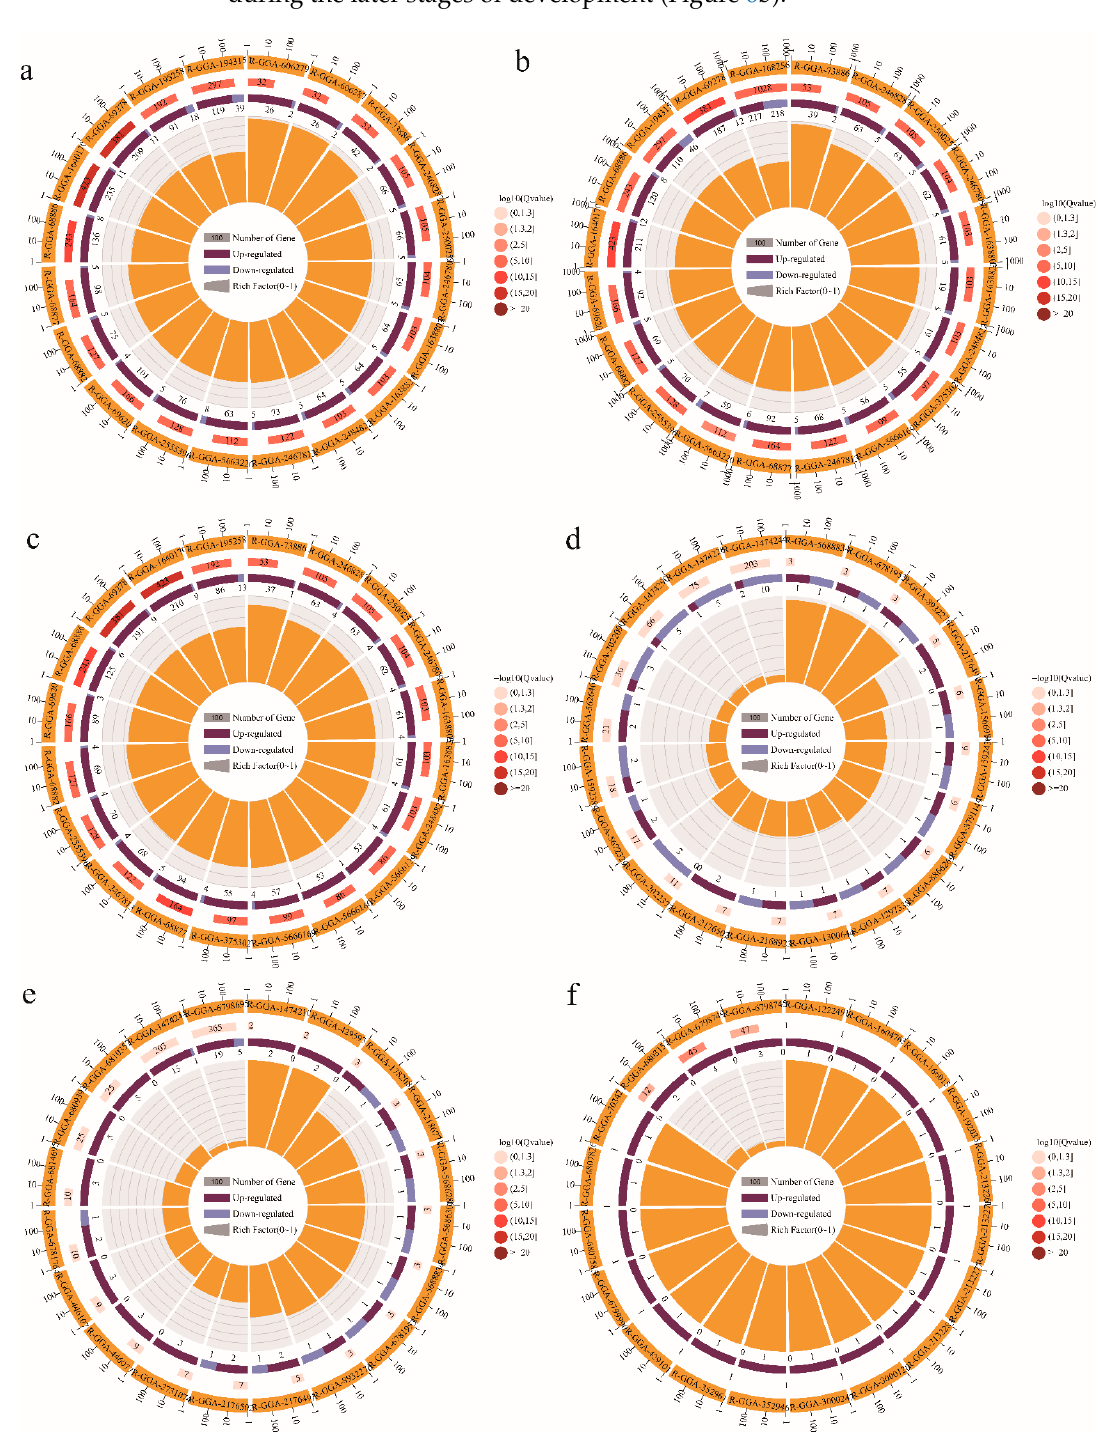
Figure 5. Circular plot of DEGs enriched by REACTOME database analysis. ( a ) Circular plot of DEGs in the N7 vs. N42 comparison group; ( b ) circular plot of DEGs in the N7 vs. N90 comparison group; ( c ) circular plot of DEGs in the N7 vs. N120 comparison group; ( d ) circular plot of DEGs in the N42 vs. N90 comparison group; ( e ) circular plot of DEGs in the N42 vs. N120 comparison group; ( f ) circular plot for DEGs in the N90 vs. N120 comparison